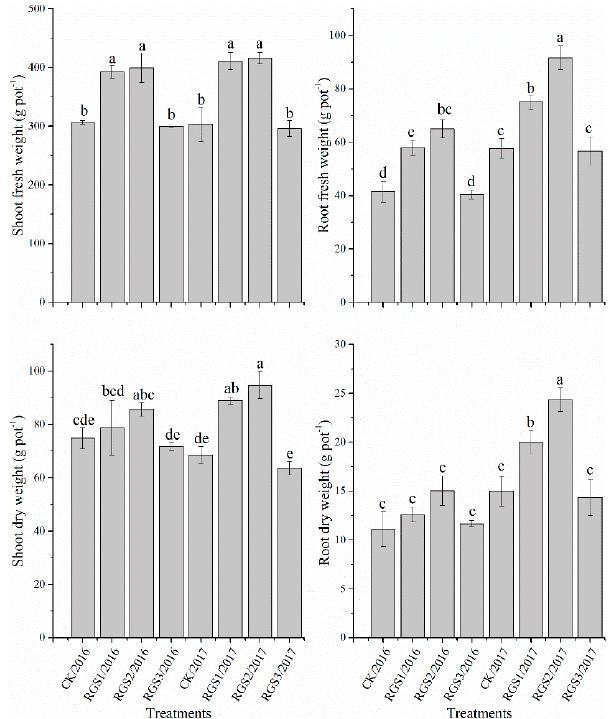
Figure 3. Effect of amendment with raw garlic stalk on shoot fresh and dry weight. Shoot fresh and dry weight ( A , B ). Root fresh and dry weight ( C , D ). The error bars represent standard error of the means ( n = 3). Different letters between treatments at different sampling stages show significant difference at p < 0.05 level (ANOVA and LSD).